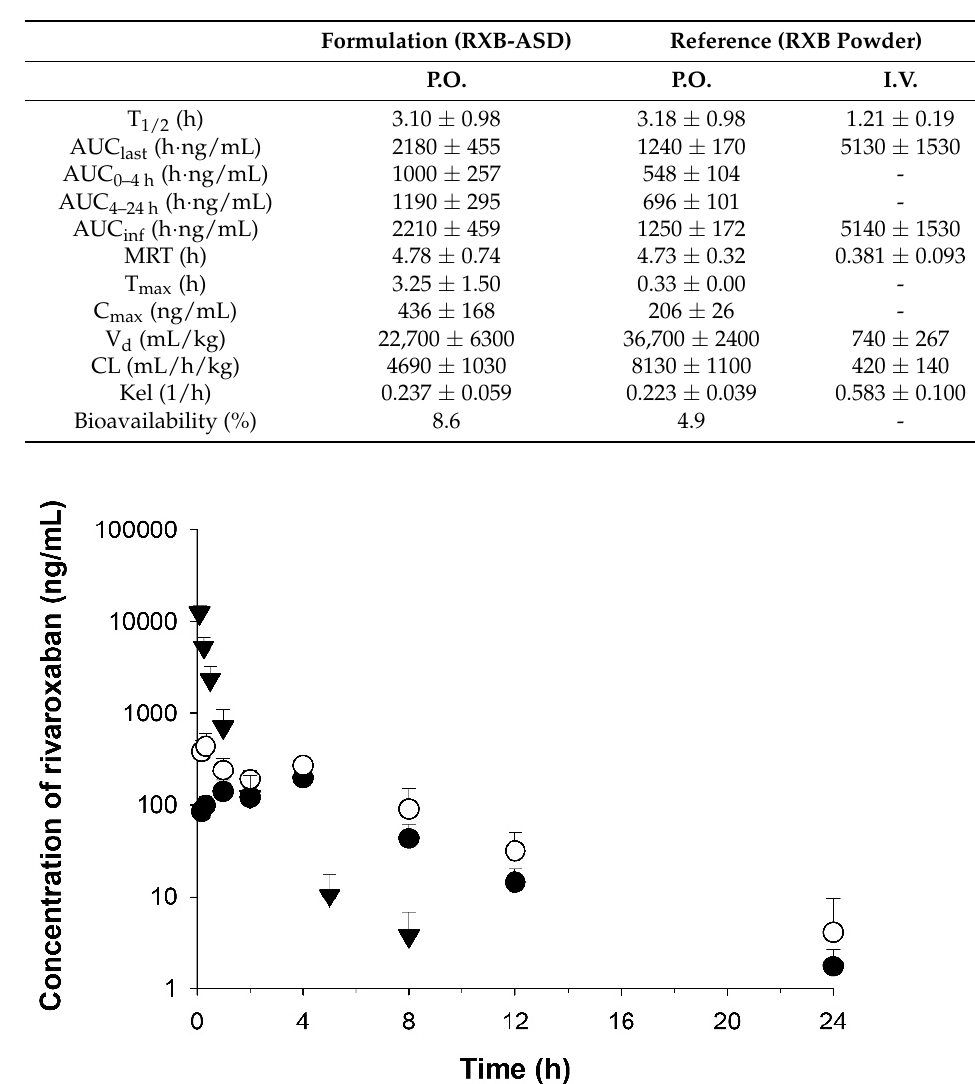
mized RXB-ASD (AUC 0–4 h , 1000 ng*h/mL; AUC last , 2180 ng*h) formulation, although the remaining 55% of the total AUC increased for 20 h, from 4 to 24 h (AUC 0–4 h , 1190 ng*h/mL; AUC last , 2180 ng*h). The half-life (T 1/2 ) and elimination rate constant (K el ) were similar in both groups, at 3.1–3.2 h and 0.223–0.237 h, respectively. Although the mean residence time (MRT) was approximately 4.7–4.8 h, and a similar value was observed for both groups, the clearance (CL) value in the HME formulation was 0.58-fold that of the powder, and the V d in the optimized RXB-ASD was 0.62-fold that of the powder. Considering CL